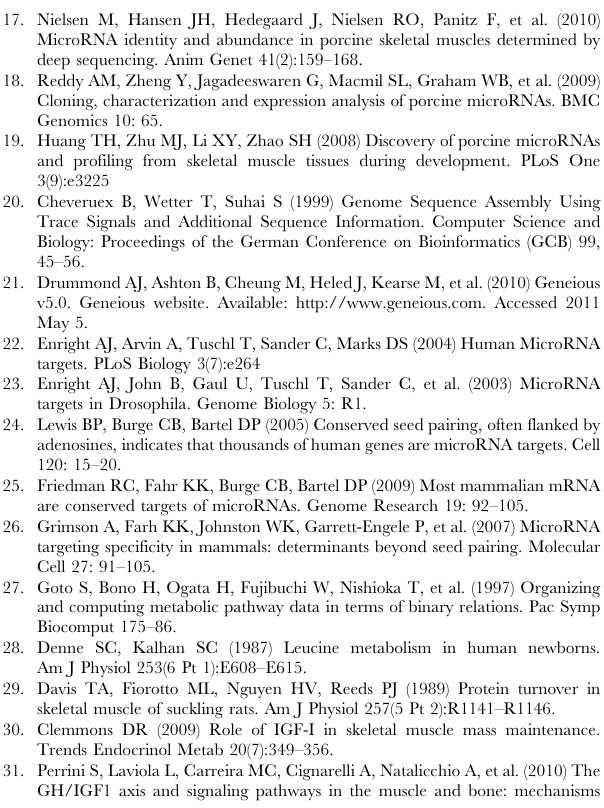
Table S2 3 9 UTR of genes targeted by highly abundant miRNA in porcine skeletal muscle as predicted by MiRanda. 3 9 UTR expressed in porcine skeletal muscle